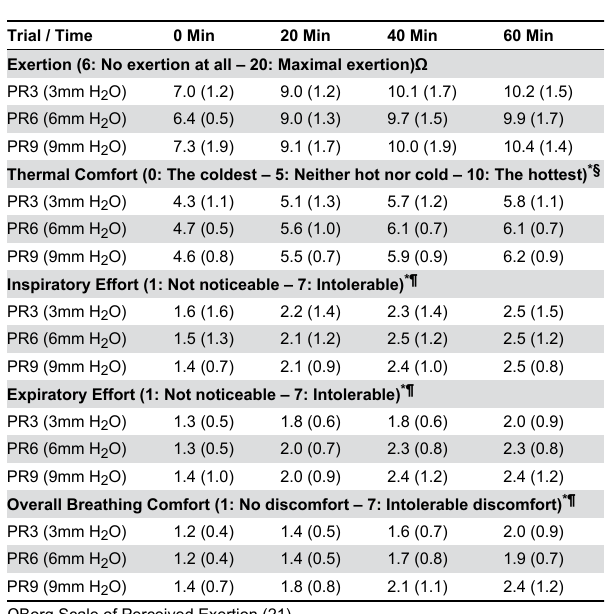
Table 3. Mean (standard deviation) subjective scores reported while wearing prototype respirators over one